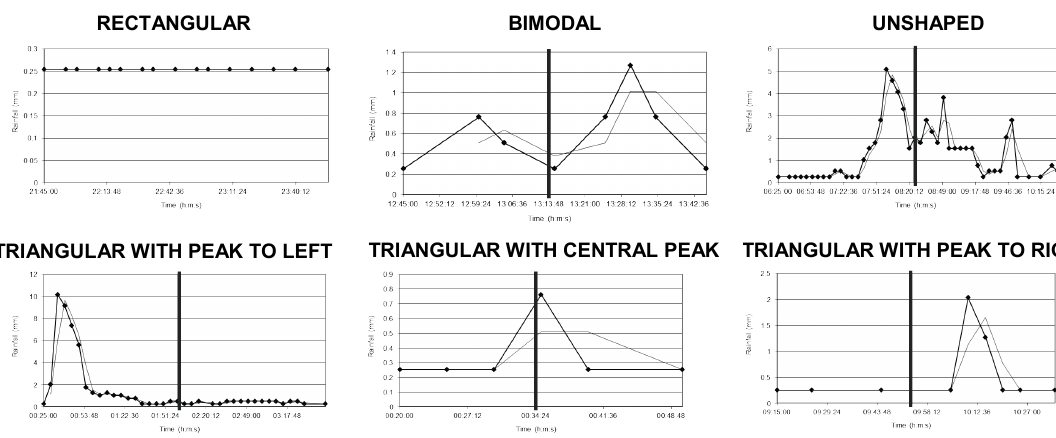
Fig. 2 Hyetograph shapes used to the